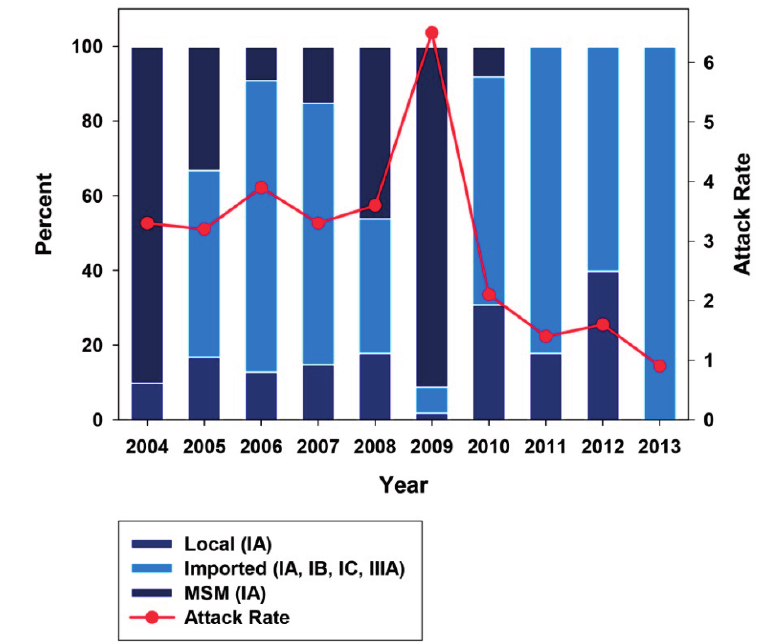
Figure 7. Origin of the HAV strains isolated in the decade 2004–2013. Data is distributed in natural years. Attack rates are defined as the number of cases per 100,000